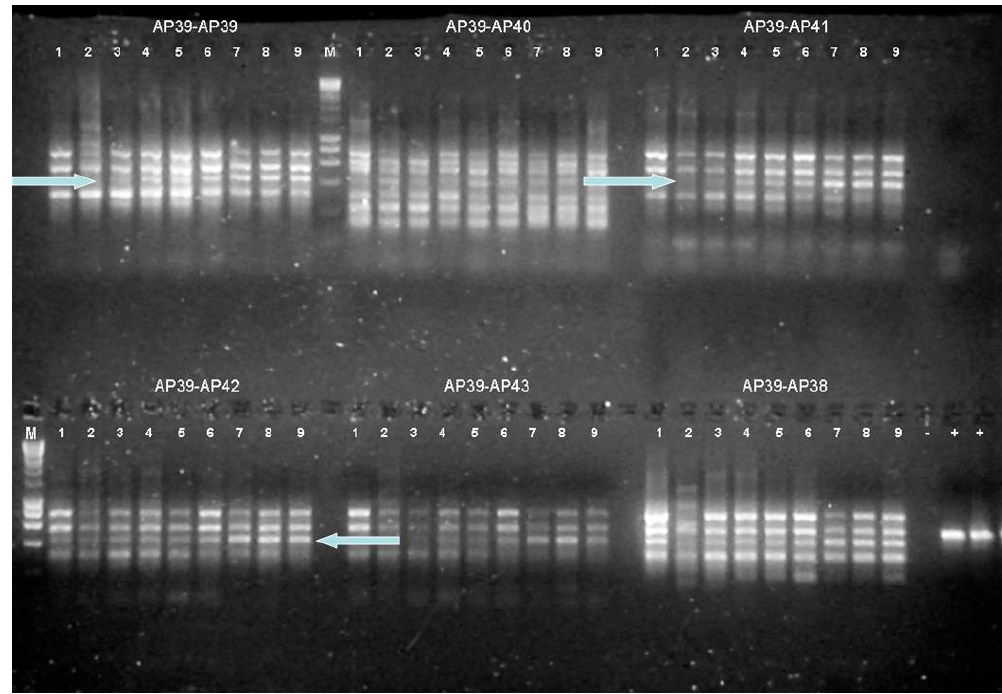
Figure 2. NA6-27 RNA arbitrarily primed PCR (RAP-PCR) fingerprint on a 2% agarose gel. Primers are indicated above the sample numbers. Arrows indicate the upregulated and downregulated